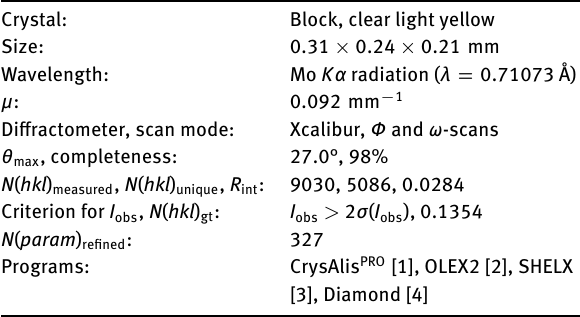
Table 1: Crystal collection and handling.